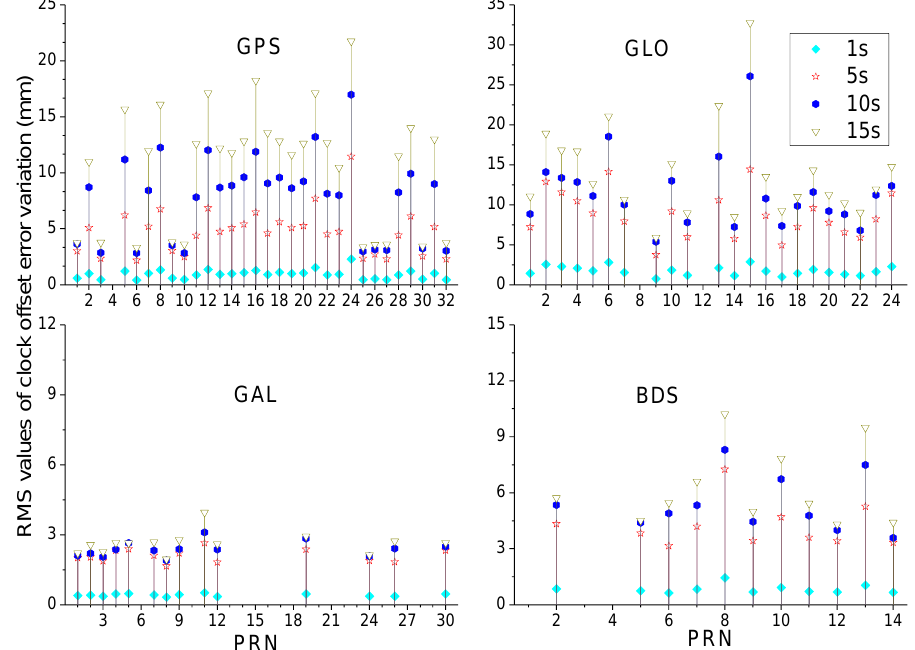
Figure 7. RMS result for 1, 5, 10, and 15 s latency variation of broadcast clock offset error on 10 January 2018.